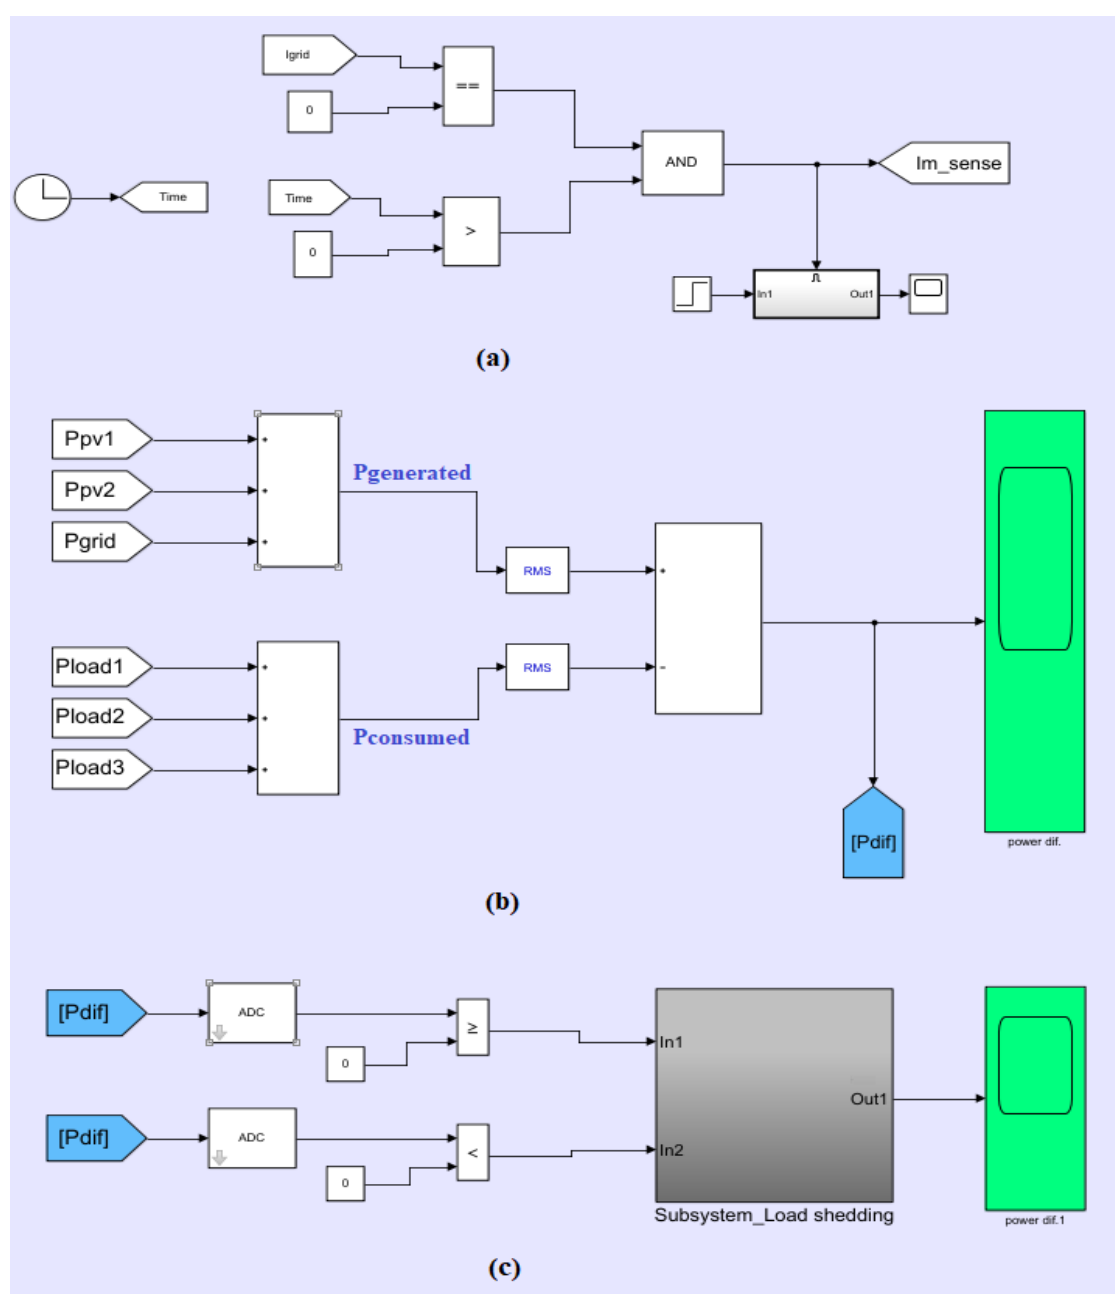
Figure 6. proposed methods modeling in MATLAB. (a): current sensing model , (b): computation of Figure 6. Proposed methods modeling in MATLAB. ( a ): current sensing model, ( b ): computation of ∆ P , ( c ): load shedding ΔP , (c): load shedding process